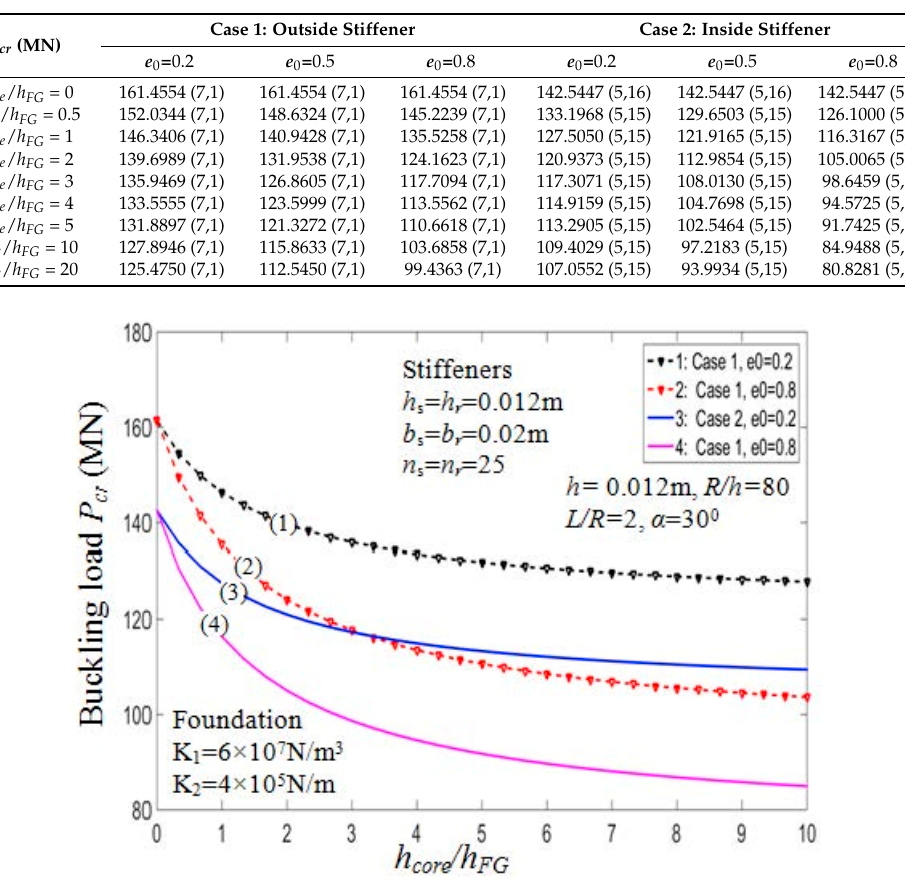
Figure 2. Effects of h core / h FG and e 0 on critical load P cr ( k 2 = k 3 = k = 1). Case 1: Outside stiffener; Case 2: Inside stiffener.